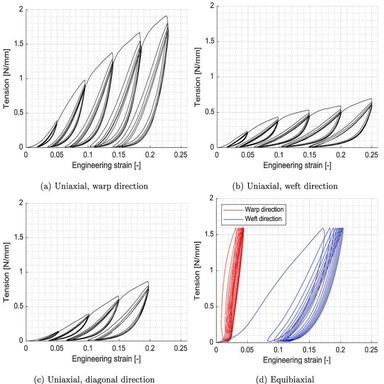
Experimental results obtained from cyclic tensile tests: tension vs nominal strain for uniaxial loading in warp (a), weft (b) and 45◦ diagonal (c) direction, and equibiaxial loading (d).